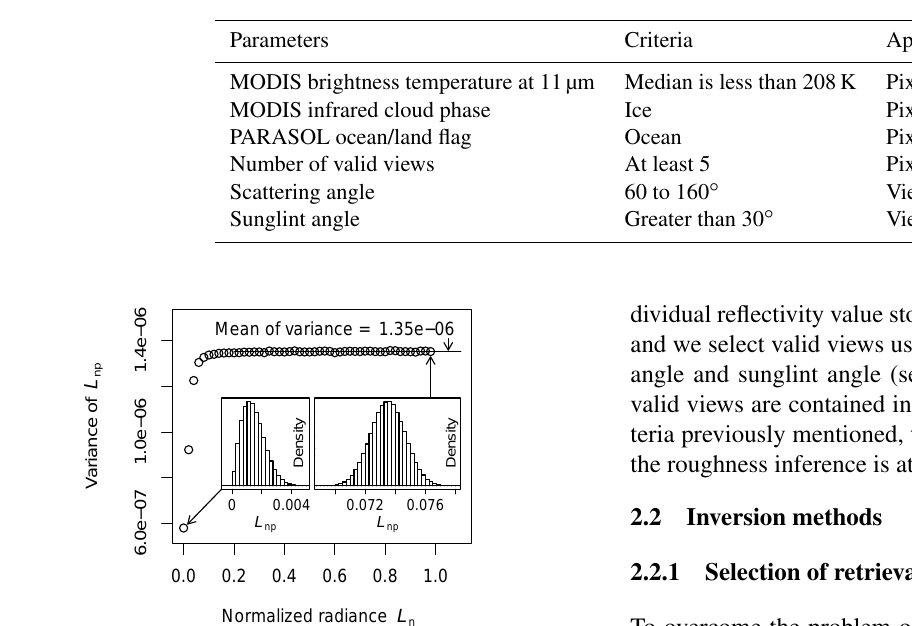
Table 1. PARASOL pixel and view selection criteria.